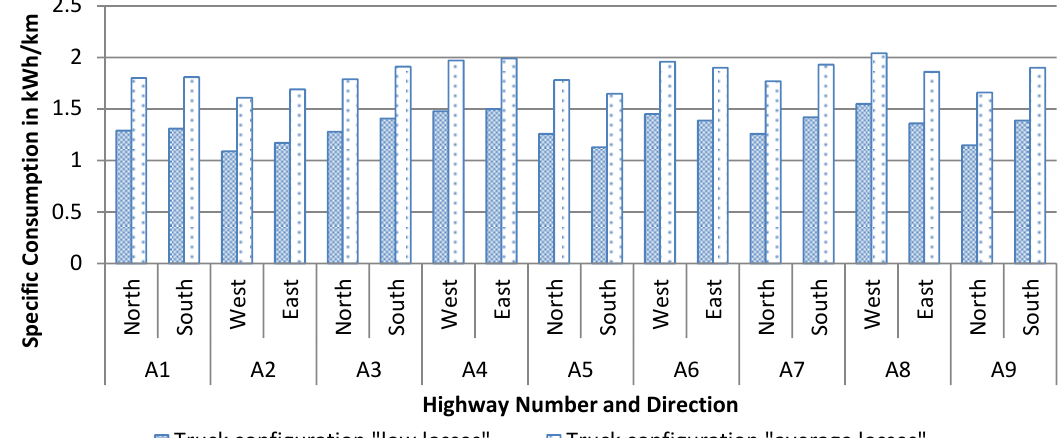
Figure 6. The specific consumption of battery electric trucks with considered configurations on different highways.